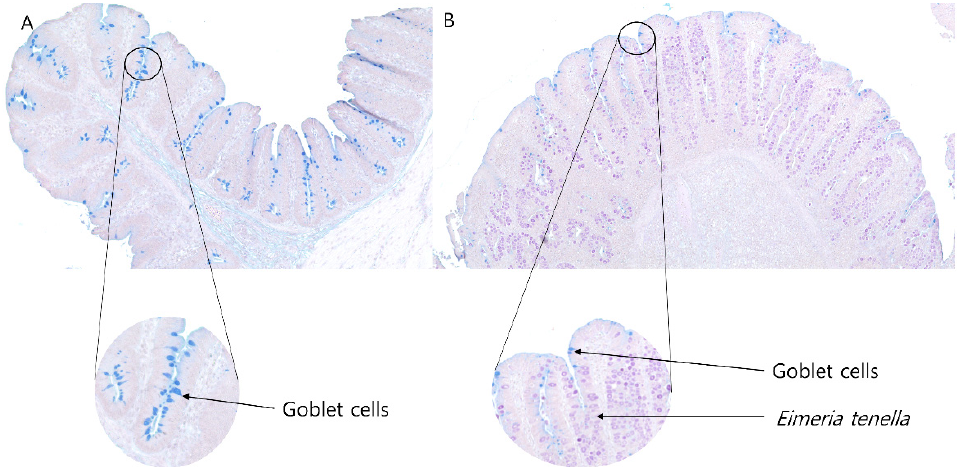
Figure 9. Goblet cells in the cecal crypt of broilers in healthy conditions ( A ) and of broilers infected with Eimeria tenella ( B ) on 6 days post-infection.